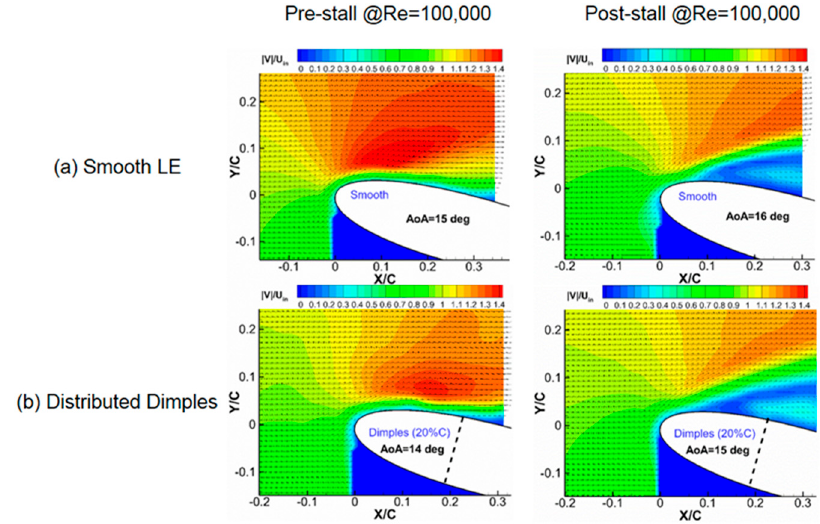
Figure 5. Averaged velocity field at high angle of attack (AoA) for the smooth ( a ) and dimpled ( b ) airfoils. Reproduced from Stolt et al. [30].